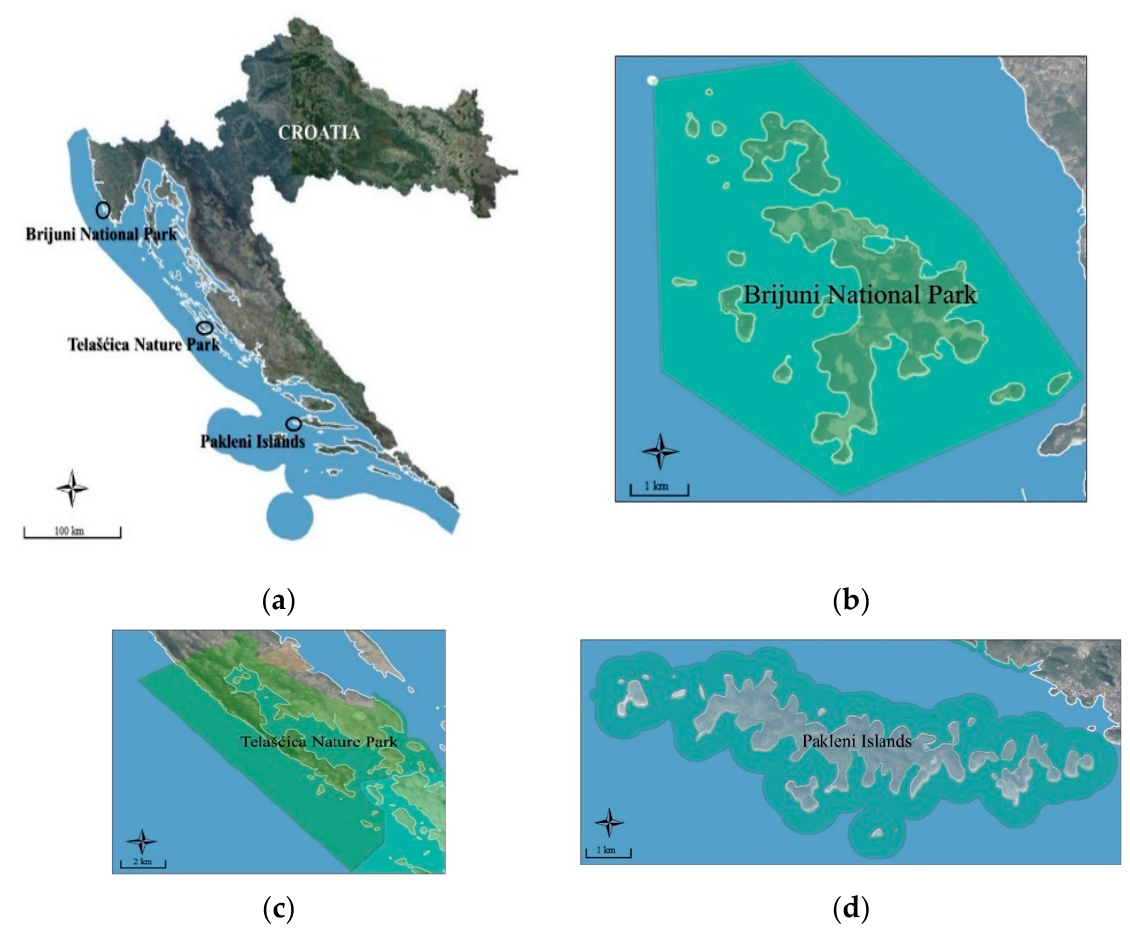
Figure 1. ( a ) Map of Croatia showing the location of the three study areas: ( b ) Map of Brijuni National Park; ( c ) Map of Telaš ć ica Nature Park; ( d ) Map of Pakleni Islands Significant Landscape.